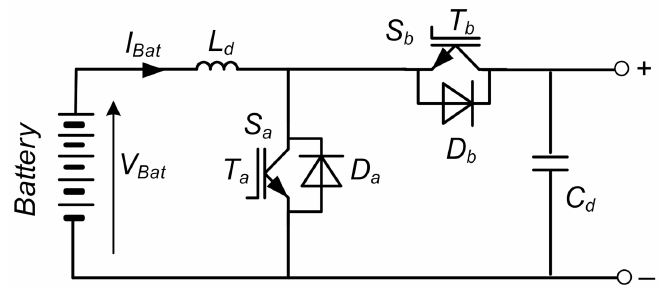
Figure 10. The bidirectional DC/DC converter for the battery system.